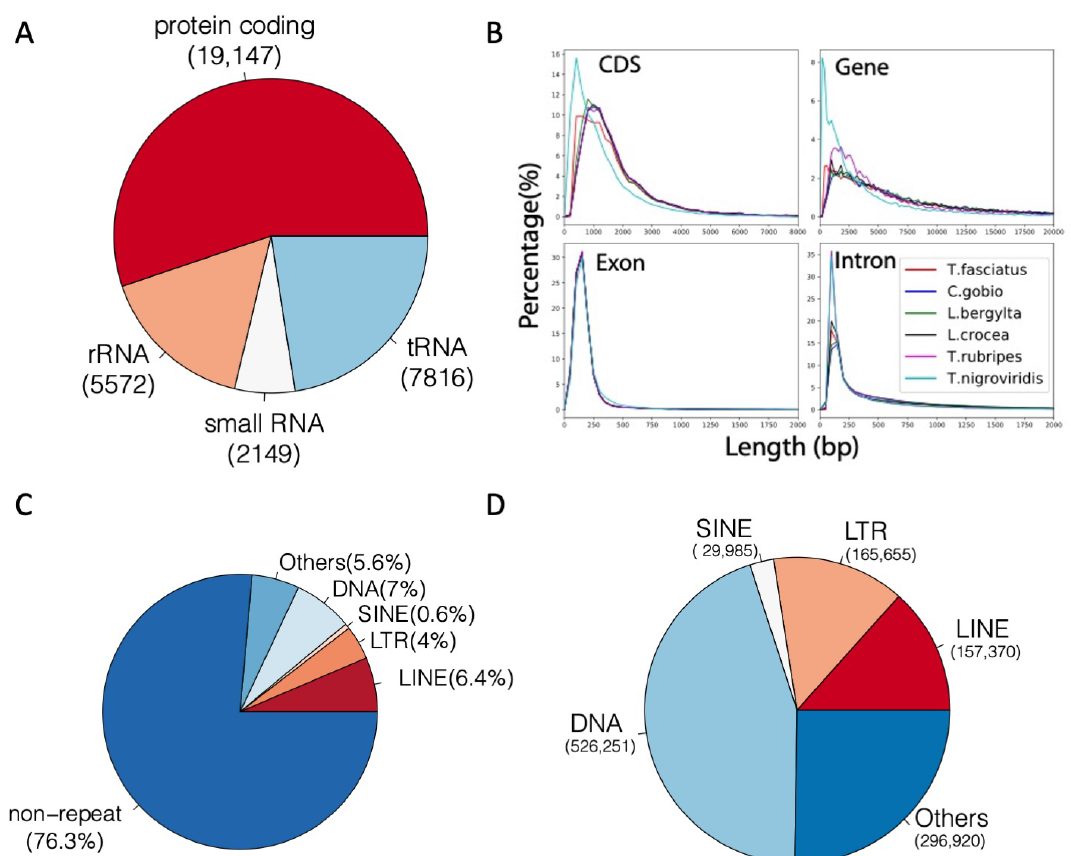
Figure 4. Summary of genome annotation for Trachidermus fasciatus . ( A ) Number of protein-coding and non-protein-coding genes. ( B ) Gene annotation length distribution compared between close species. ( C ) Percentage of genome occupied by repetitive elements. ( D ) Number of repetitive elements in each class.